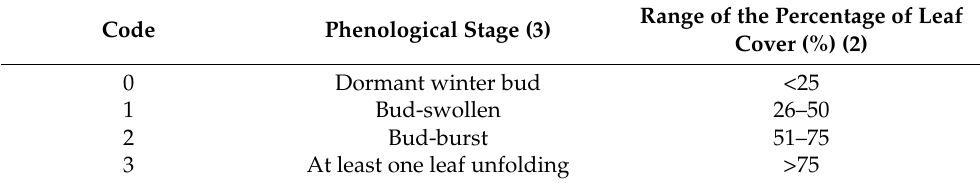
Table 2. Phenological stages linked to the observed percentage of leaf